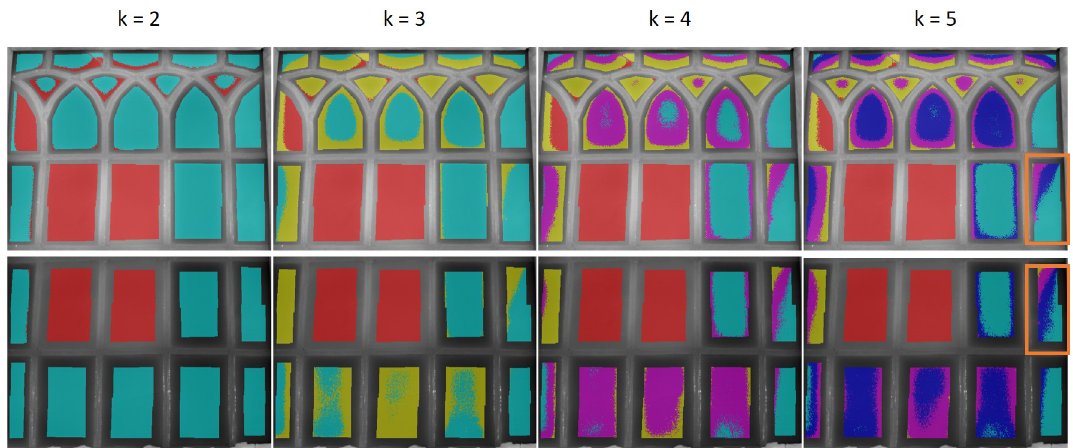
Figure 6. Results for k-means clustering on the reflective thermography dataset. The amount of clusters increases from left to right. While the false colors in the upper and lower images match, in order to make it easier to interpret the results, they do not represent the same clusters because the upper region and lower region datasets were processed separately. The grey areas were masked